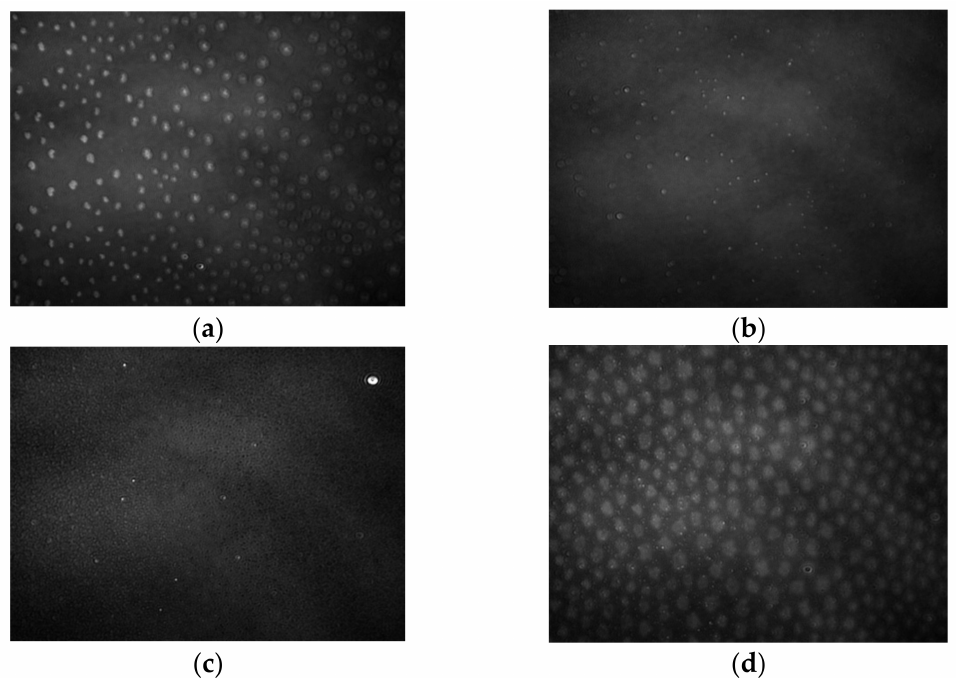
Figure 11. BAM images taken for the PC–K system in a 1:1 ratio at four surface pressure: ( a ) 0.11 mN/m, ( b ) 7.83 mN/m, ( c ) 24.71 mN/m, ( d ) 48.16 mN/m.The images were captured during compression at constant temperature and surface pressure in the field of view 3.6 × 4.0 mm. A black glass plate immersed in the subphase absorbed the refracted beam. The resolution of image was approx. 6 µ